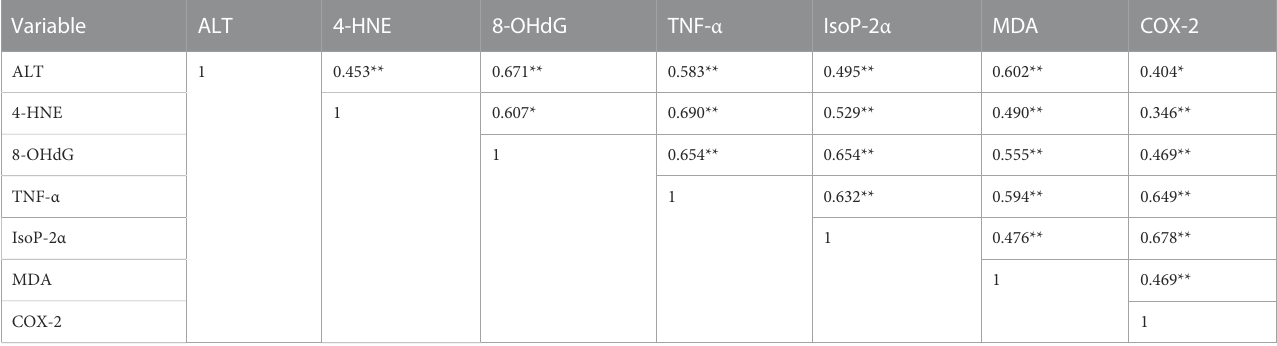
TABLE 6 Pearson ’ s correlation coef fi cients of different variables in liver tissues of rats stimulated with Cd.